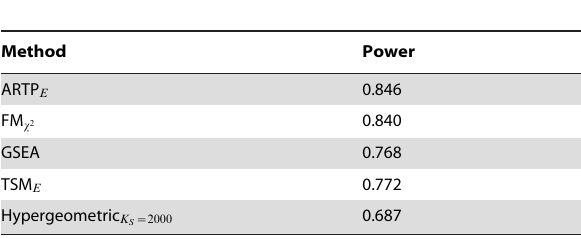
Table 5. Mean power of the methods that have a type-I error 5% across all simulated